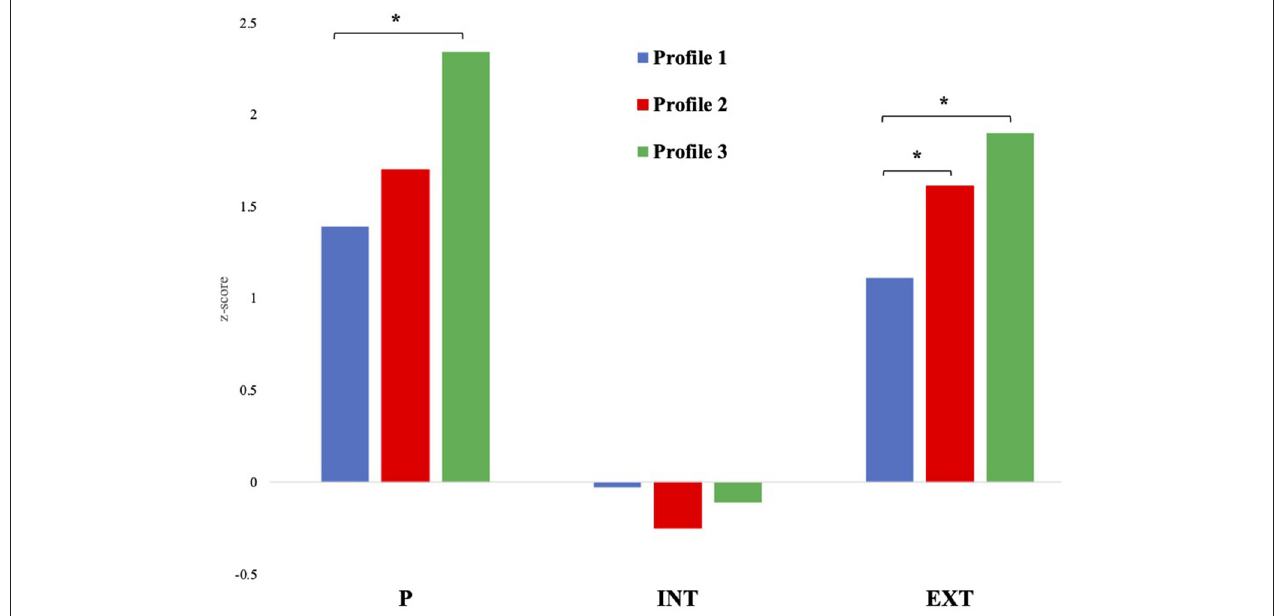
FIGURE 2 | Latent profiles by General Factor of Psychopathology (P), Internalizing (INT), and Externalizing (EXT) factor scores from the Parent Report CBCL. *denotes differences in P, INT, and EXT factor scores that are significantly different at p < 0.005.